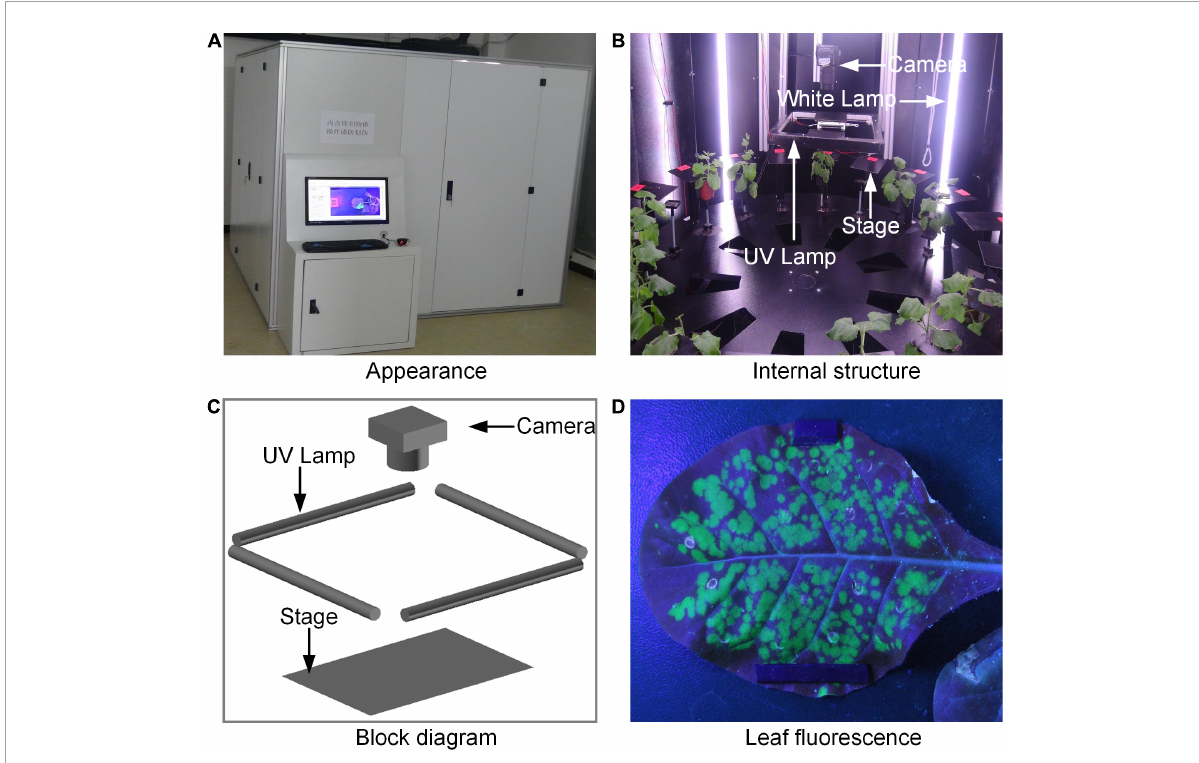
FIGURE1 The prototype of fluorescence phenotyping platform: (A) Appearance of the platform, (B) the inter structure of the platform, (C) the block diagram of the acquisition part, and (D) the acquired leaf fluorescence